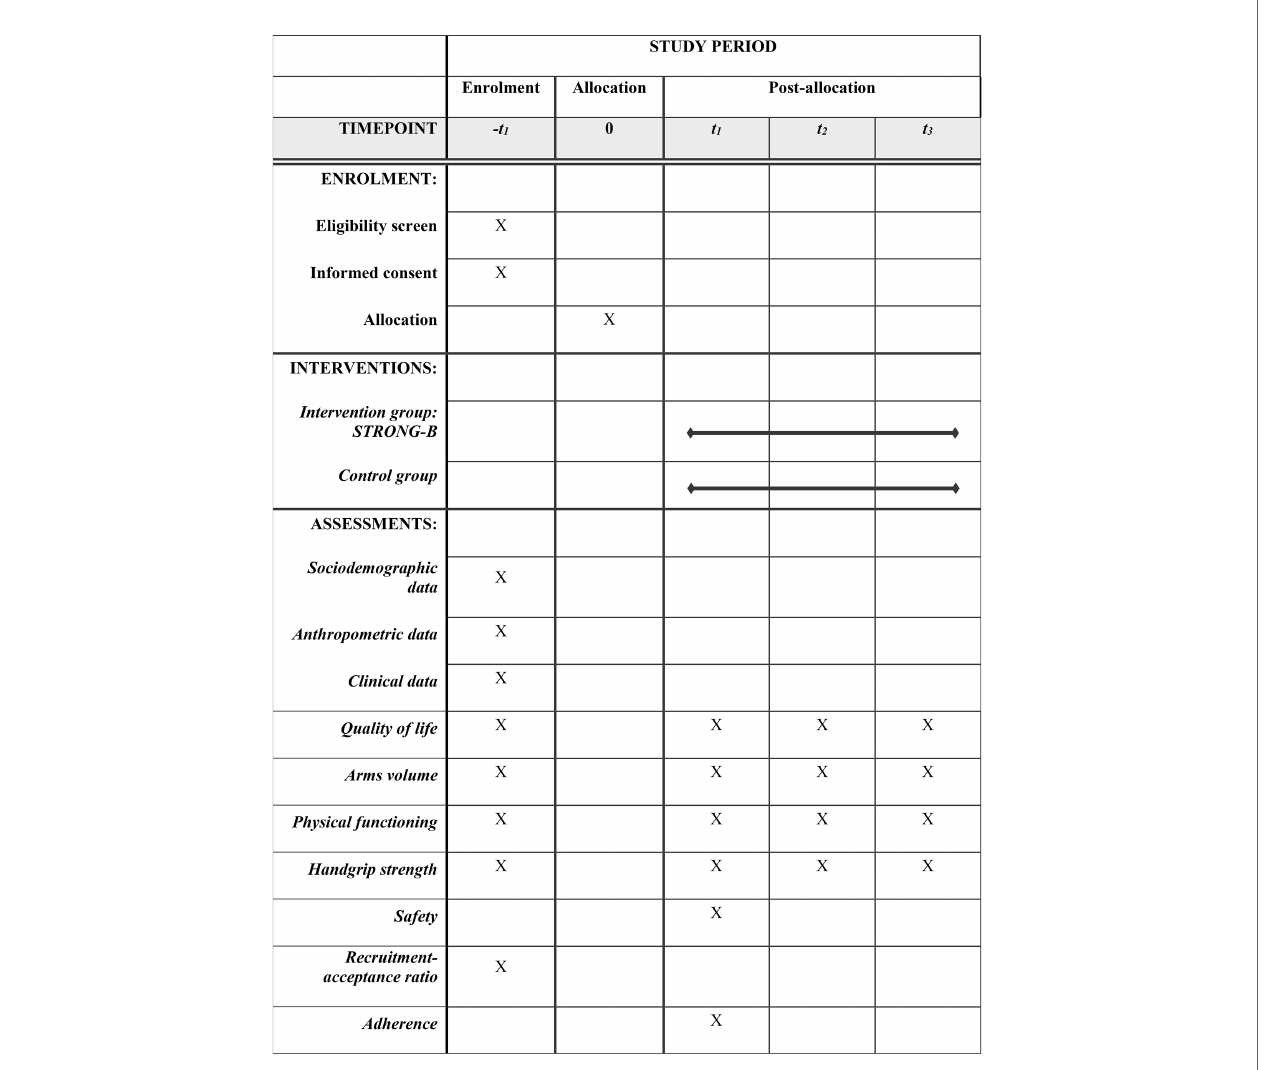
FIGURE 1 | Schedule of enrolment, interventions, and assessments according to SPIRIT